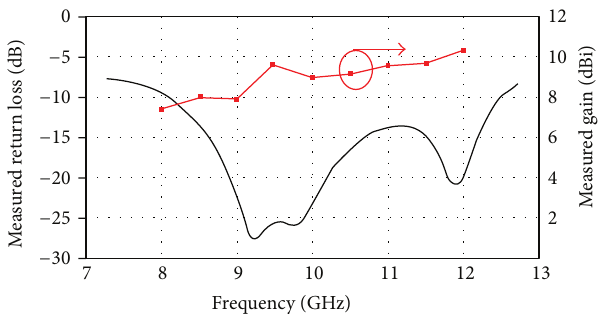
Figure 10: Measured return loss and directive gain of the fabricated